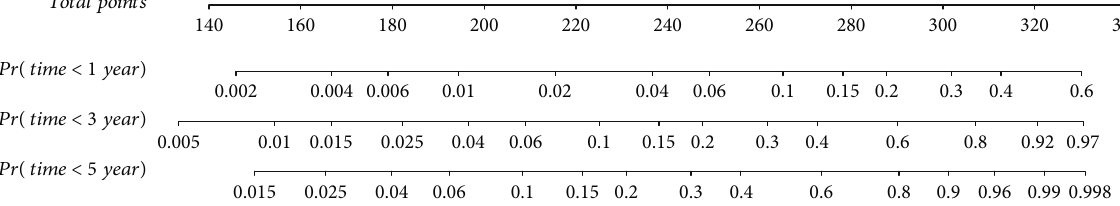
Figure 1: Nomogram predicted 1-, 3-, and 5-year cancer-speci fi c death for patients with resected rectal cancer based on 6 available clinical characteristics. For each predictor, read the points assigned on the 0 – 100 scale at the top and then add these points. Find the number on the “ total points ” scale and then read the corresponding predictions of 1-, 3-, and 5-year cancer-speci fi c death risk using the competing-risk